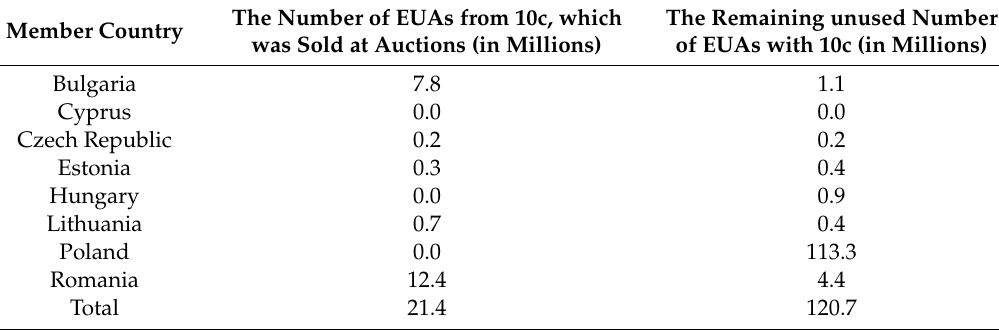
Table 2. Purpose of unused entitlements from the derogation in 2013–2017. The Number of EUAs from 10c, which Member Country